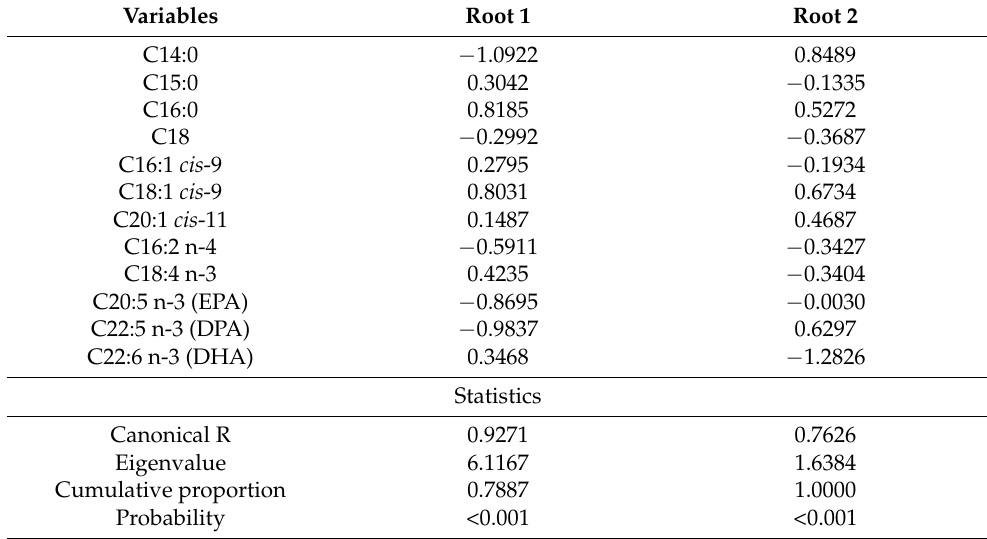
Table 3. Results of the canonical discriminant analysis: loadings of the correlation matrix between predictor variables (standardized canonical coefficients) and discriminant functions (roots 1, 2 and 3), and some statistics for each function.